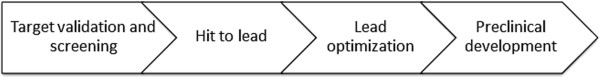
Diagram of major milestone transition and go/no-go decision points in the discovery phase of pharmaceutical R&D leading to preclinical development. Details as follows: (1) Conduct exploratory work that includes project conception, target validation and screening. (2) Identify chemical lead(s) and establish target drug profile. (3) Optimize chemical properties and biological activity against the target drug profile. (4) Complete all necessary studies to allow an investigational new drug (IND) application to be filed.